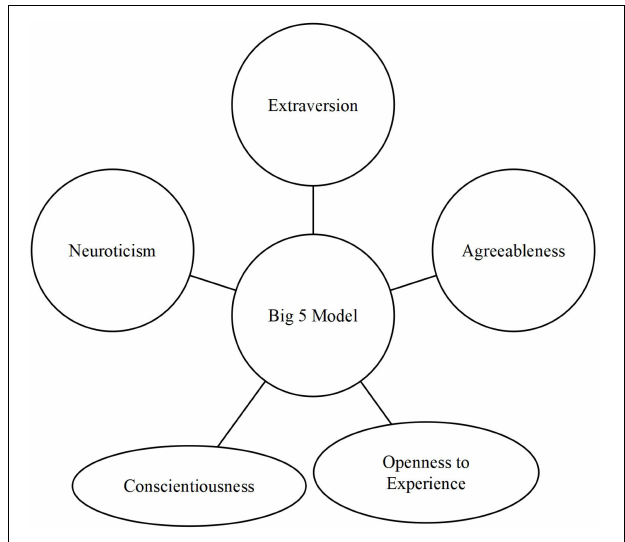
FIGURE 1 | Big Five personality traits